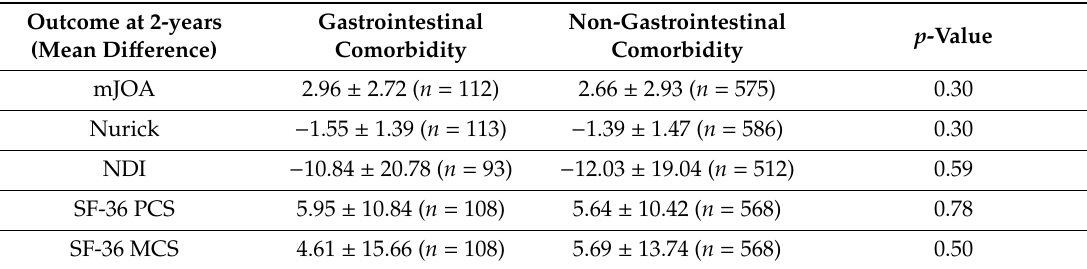
Table 2. Surgical outcome at 2-years follow-up.